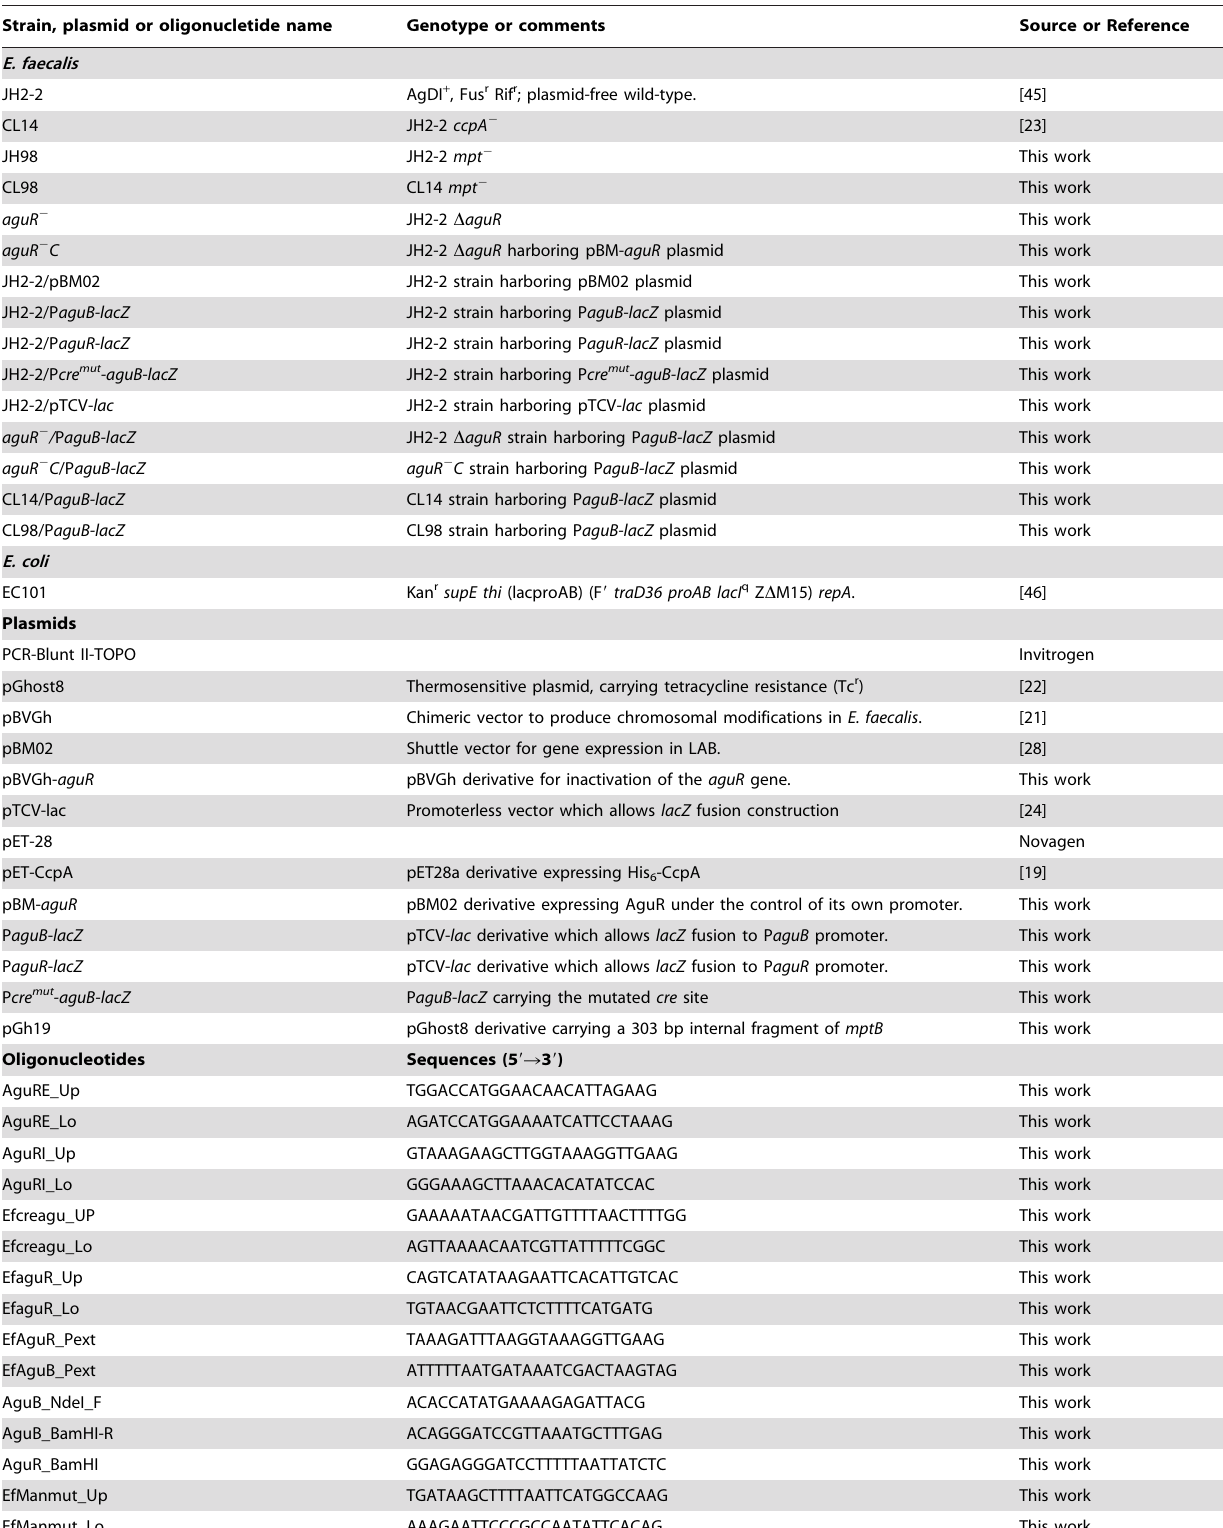
Strain, plasmid or oligonucletide